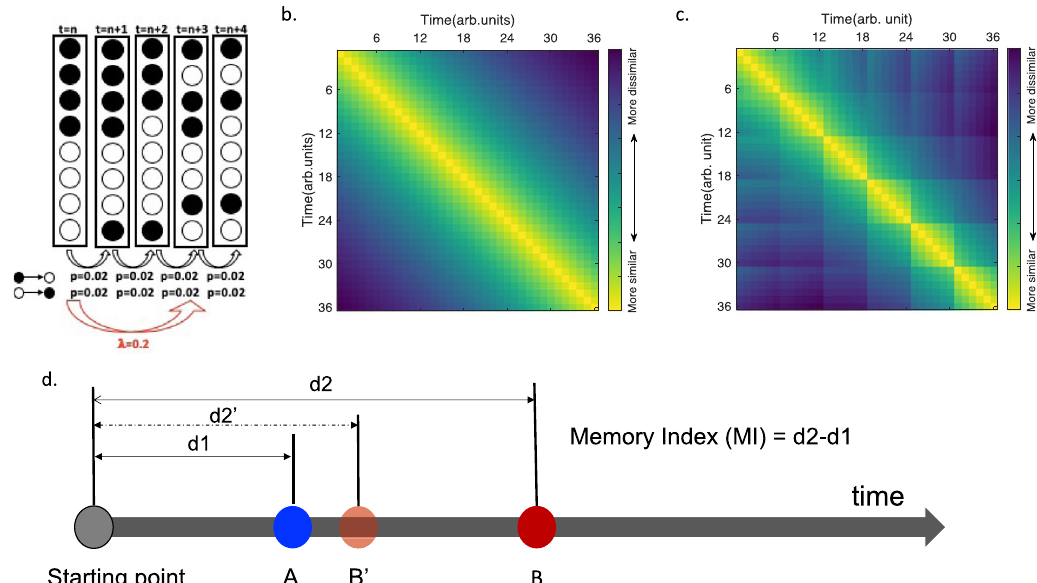
Fig. 4 Computational model. a Schematic of the model. The context signal was de fi ned as a vector of binary elements, which drifts at rate p when there is no event boundary and resets at rate λ at event boundaries. b , c shows representational dissimilarity (1-R) for each time point relative to all the other time points averaged over 1000 iterations of the simulation of the model containing no event boundaries ( b ) and the model containing 5 event boundaries (i.e., event boundary occurred every 6 time points, c ), respectively. d Schematic of the memory index (MI) used to quantify recency judgments. To make a recency judgment, the learning contexts of each probed object is reinstated, and compared to the contextual representation of the fi rst time point during encoding (i.e., d1 and d2, which refer to the representation dissimilarity between each of the probed items and the reference item). The one more dissimilar with the reference point (quanti fi ed by d2-d1) is judged as the item presented later. arb. units refers to arbitrary units. Source data are provided as a Source Data fi